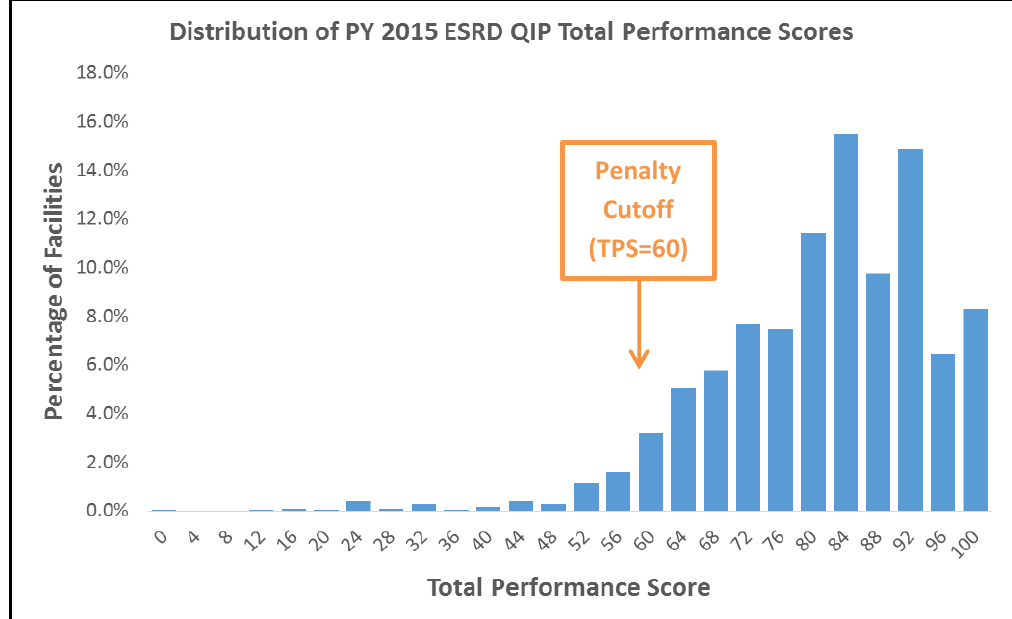
Figure 11.3: Distribution of PY 2015 ESRD QIP Total Performance Scores